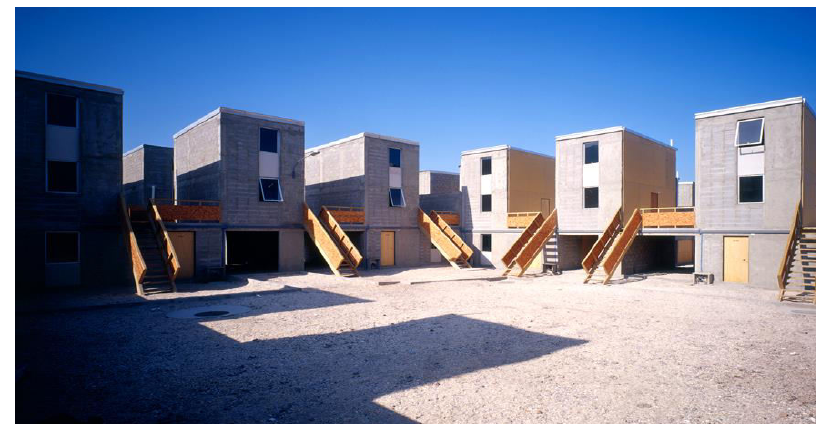
Figure 2: Elemental ’ s Iquique development, Chile. Archdaily.com,